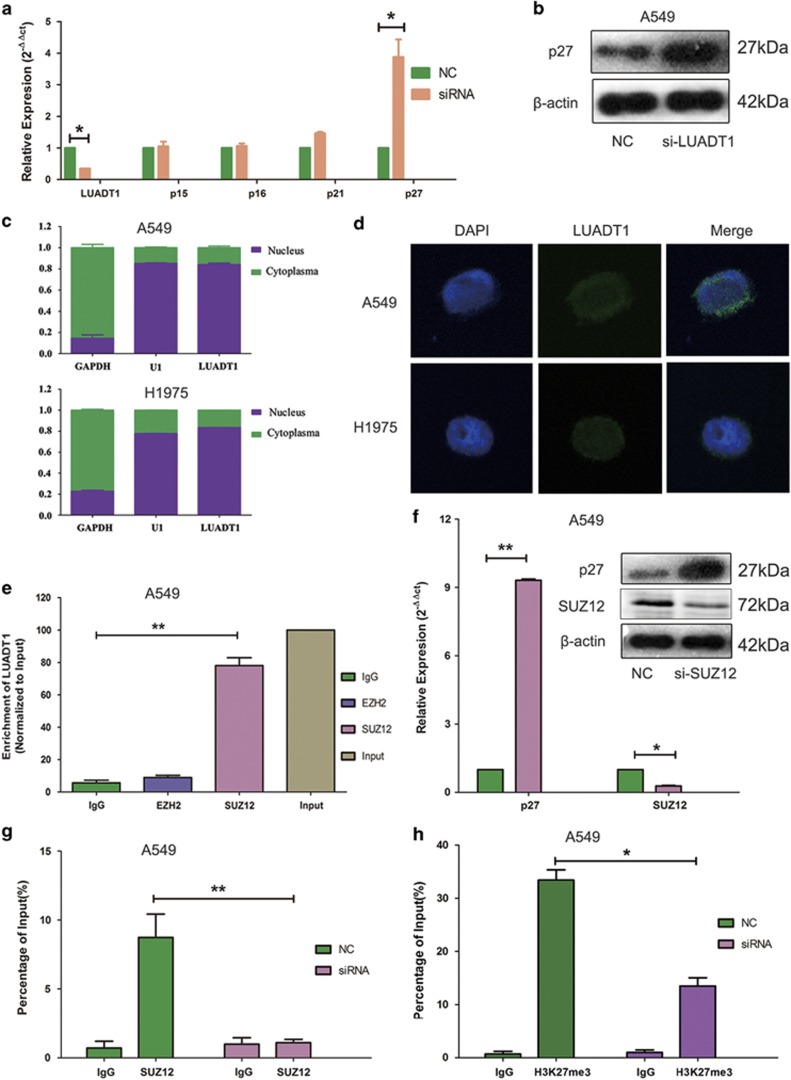
LUADT1 binds to SUZ12 to suppress p27 expression. The expression of cell cycle-related genes was analyzed after LUADT1 knockdown (a). Significant upregulation of p27 was observed and was confirmed by western blot (b). Cell fractionation assay revealed that LUADT1 is predominantly located in nucleus, and GAPDH and small nuclear RNA U1 were used as control genes of cytoplasm and nucleus (c). Fluorescence in situ hybridization assay demonstrated that most LUADT1 was located in nucleus (d). An RIP assay confirmed that LUADT1 binds to SUZ12, although the interaction between EZH2 and LUADT1 was not apparent (e). The silencing of SUZ12 decreased p27 expression at the mRNA and protein levels (f). The enrichment of SUZ12 and trimethylated H3K27 in the promoter region of p27 was detected via ChIP, and this enrichment was decreased after LUADT1 knockdown (g and h). *P<0.05, **P<0.01. Error bars indicate means±S.E.M.